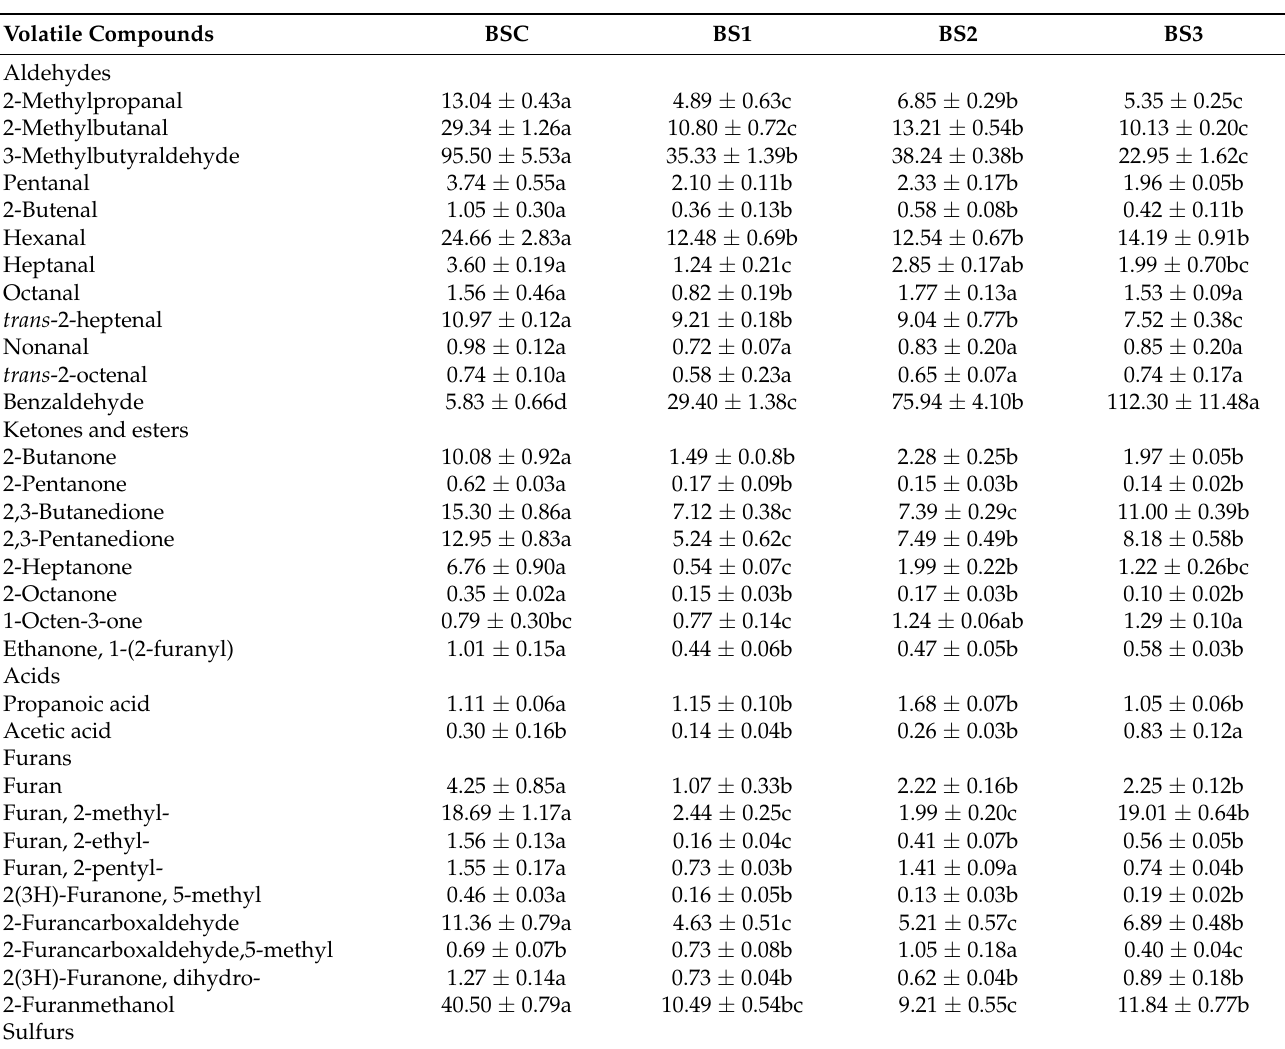
Table 4. Mean values, standard deviation, and results of statistical analysis of the volatile compounds (expressed as µ g g − 1 ) into GF